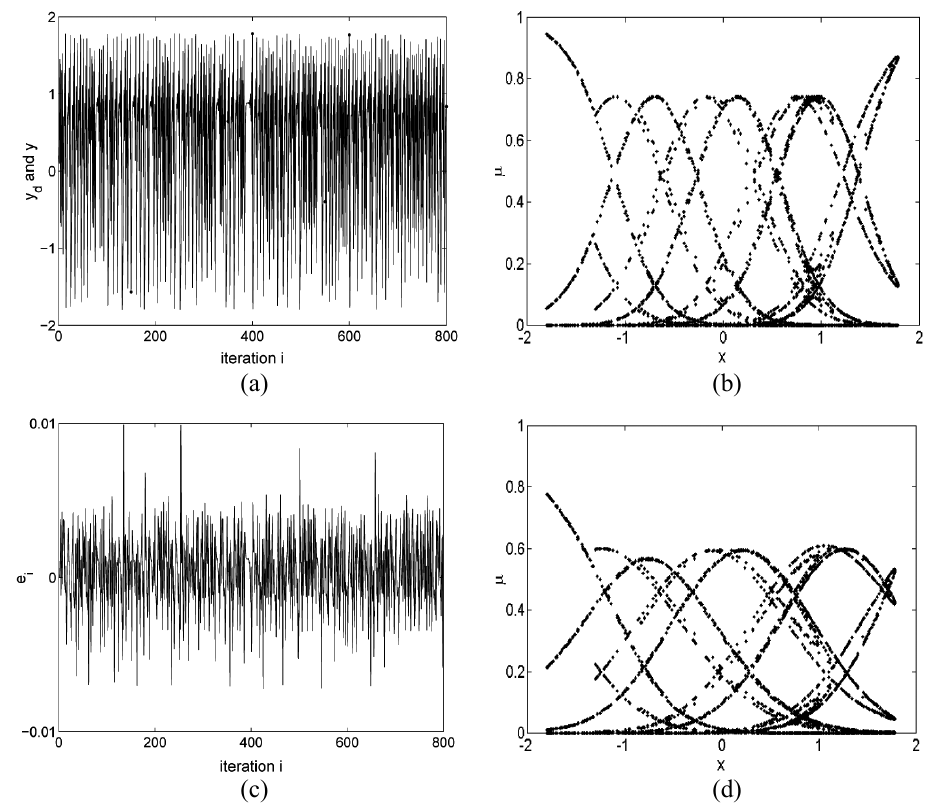
Fig. 7. T-S Fuzzy modeling of the Henon system. (a) Input-output data and fuzzy model. (b) Initial MF. (c) Modeling error. (d) Final